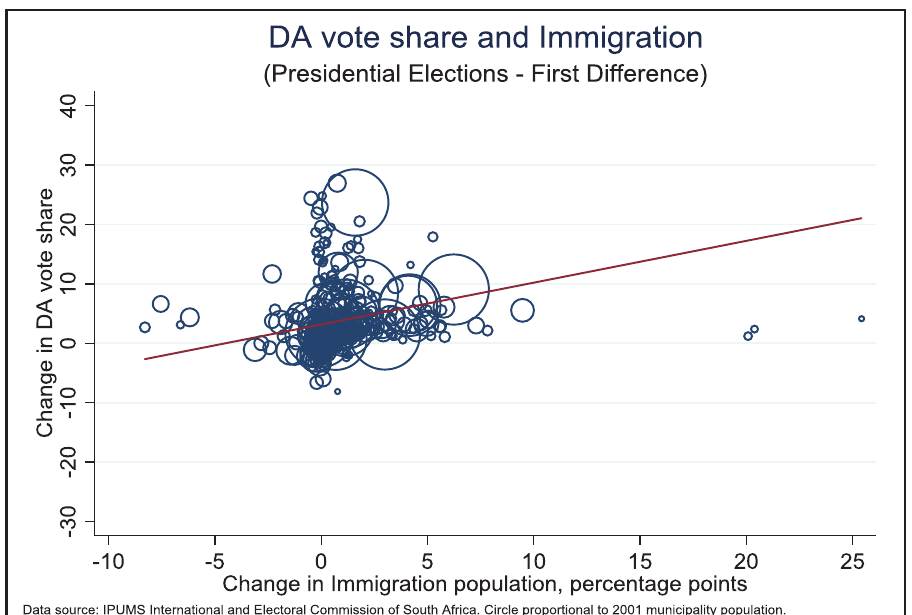
Figure 11 DA vote and